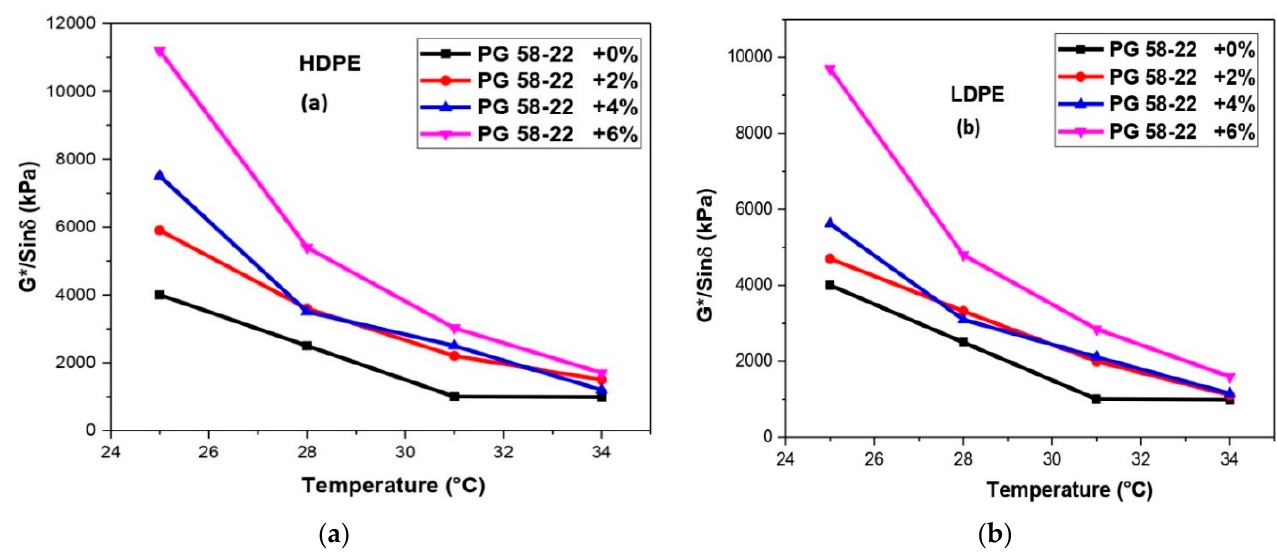
Figure 8. ( a ) An analysis of G*/Sin ( 𝛿 ) and temperature with HDPE modified bitumen for long-term aging, ( b ) an analysis of G*/Sin ( 𝛿 ) and temperature with LDPE modified bitumen for long-term aging.